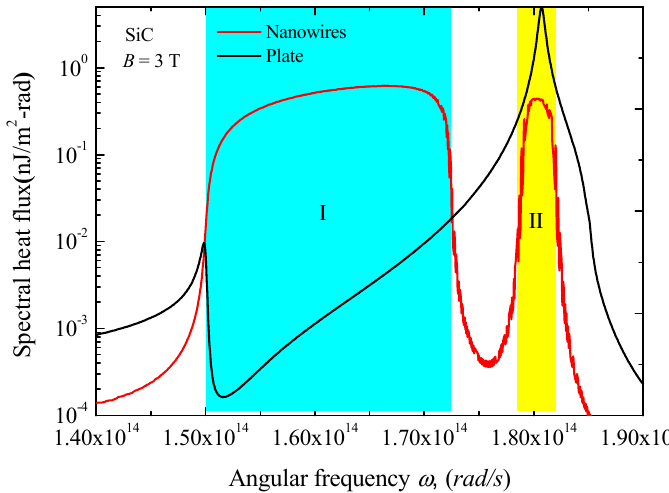
Figure 5. Spectral heat fluxes between two aligned SiC nanowires and between two SiC plates with f = 0.2 at d = 10 nm.